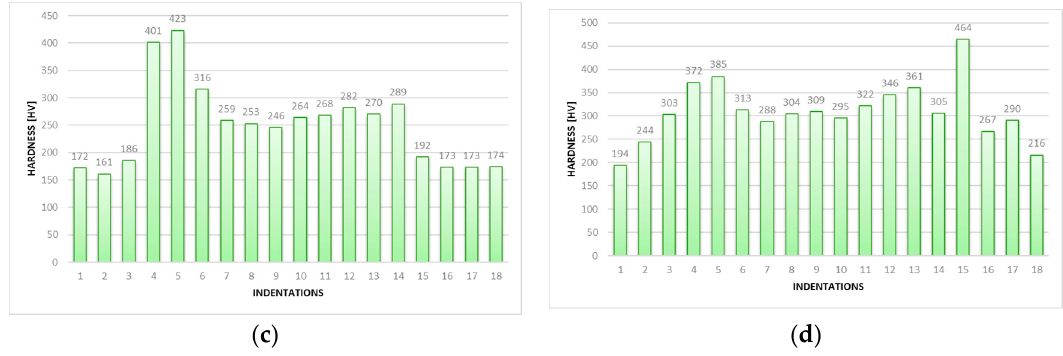
Figure 15. Hardness test analysis results: ( a ) illustration of indentations row on sample